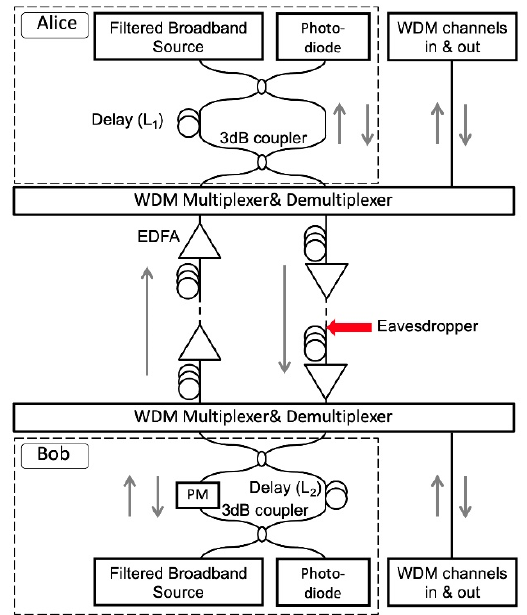
Figure 1. Experimental setup. (EDFA: erbium-doped fiber amplifier; WDM: wavelength-division multiplexing; PM: phase modulator).